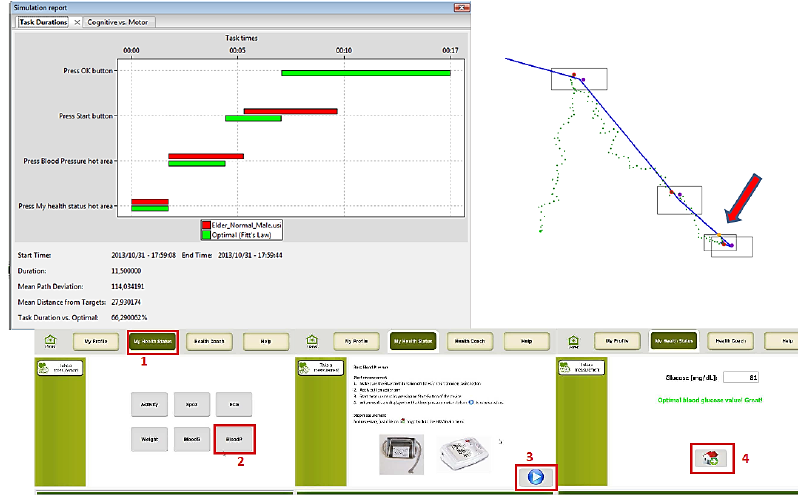
Figure 11. User 1 Cognitive VUM simulation: Take Measurements.